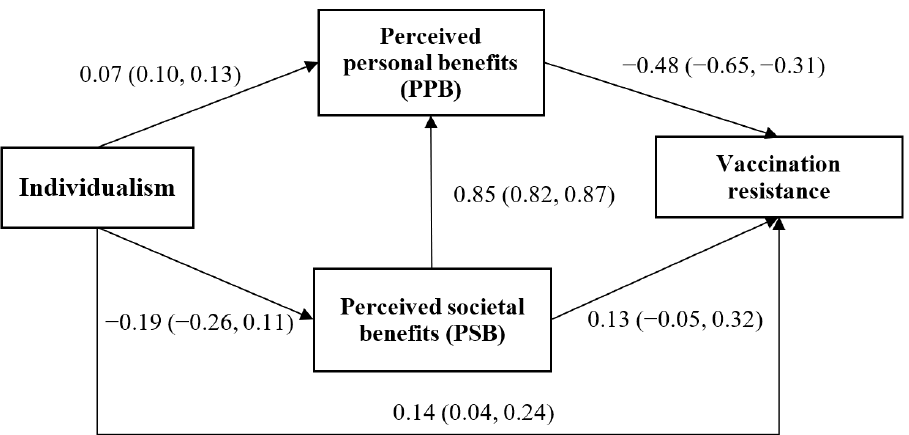
Figure 1. Path analysis of the mechanisms between individualism and vaccination resistance (Standardized beta coefficients and respective 95% confidence intervals were reported).